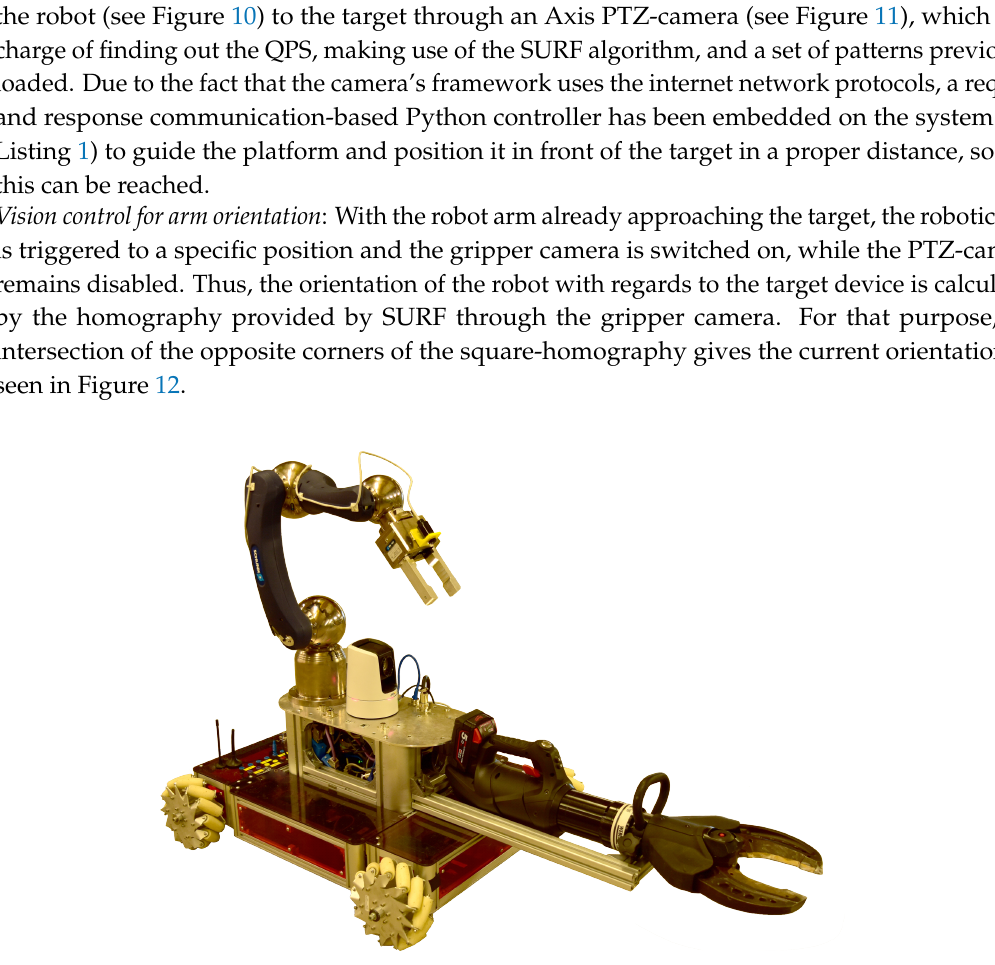
Figure 10. CERNBot in scorpion setup. Here it can be seen how the robot wears the two kind of Axis cameras outline above.